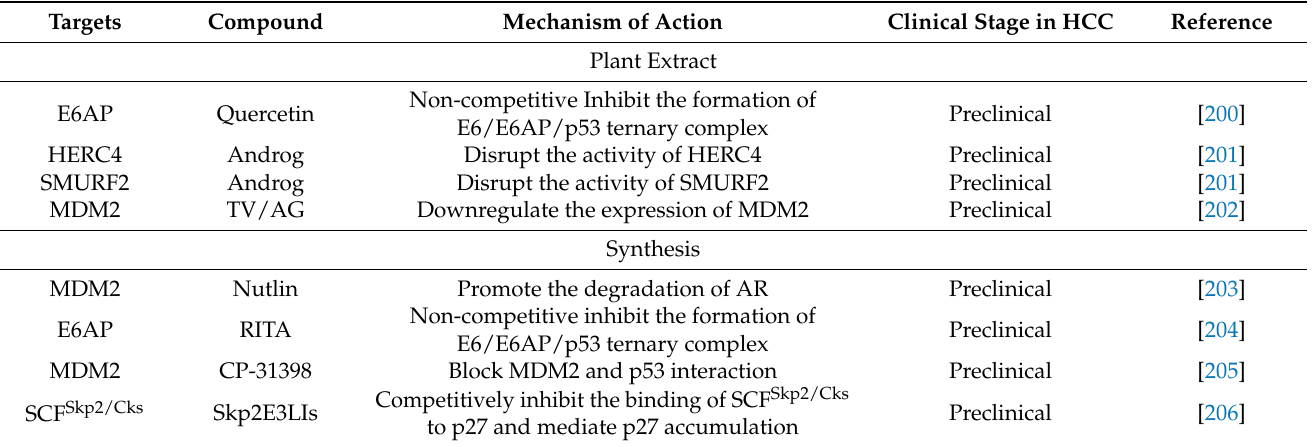
Table 4. Summary of inhibitors targeting the E3s in EC and